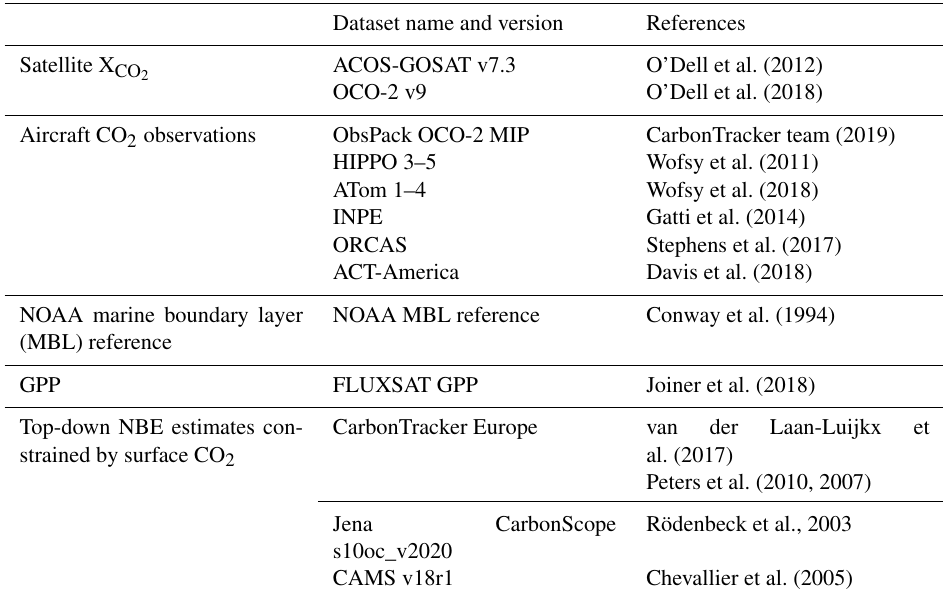
Table 3. Description of observation and evaluation dataset. Data sources are listed in Table